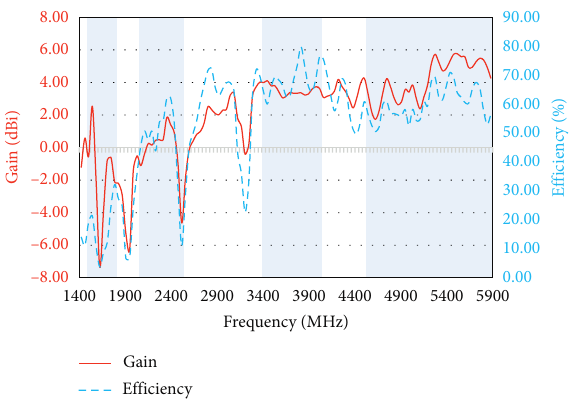
Figure 16: Measured gain and efficiency